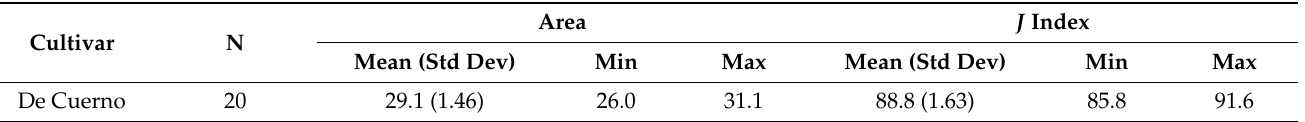
Figure 22. From left to right: A sum of the silhouettes of 30 seeds, a silhouette obtained by the pixel profile of the first image, the De Cuerno model, and four representative De Cuerno seeds. Bar represents 1 cm. Table 12. Values of area and J index in the De Cuerno